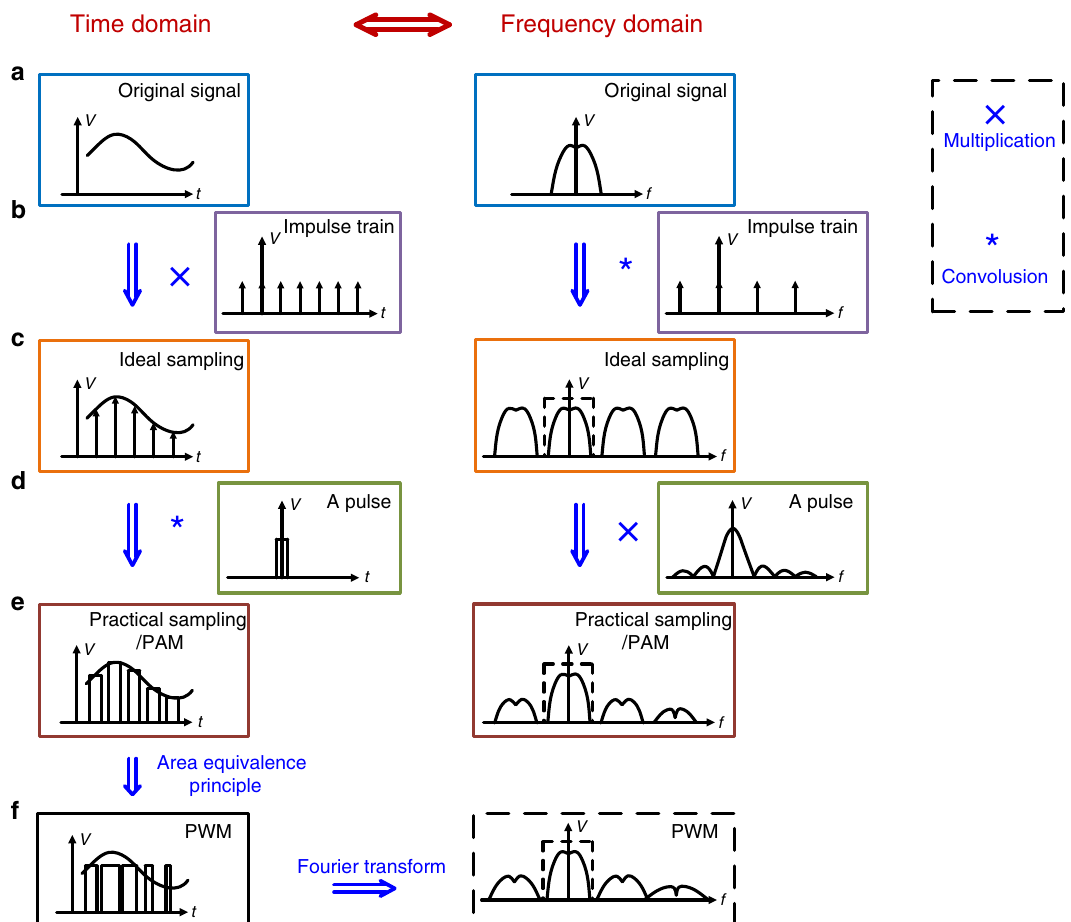
Fig. 1 Waveforms and spectrum corresponding to sampling and modulation. This fi gure shows the relationship between sampling, PAM and PWM. Both time-domain waveforms and frequency-domain spectrum are depicted. a The continuous original signal to be sampled or modulated. b An impulse train, which is a sequence of Dirac functions and can be employed as a sampling function. c The ideal sampling result, which is the result of the multiplication of a and b in the time domain and convolution in the frequency domain. d A pulse in the time domain and its corresponding spectrum. e The sampling result obtained in practice, in which case the periodic sequence of impulses (Dirac functions) is replaced with a sequence of pulses of equal width. This process is also known as PAM. This result is derived through the convolution of c and d in the time domain and multiplication in the frequency domain. f The result of PWM — derived from e in the time domain based on the area equivalence